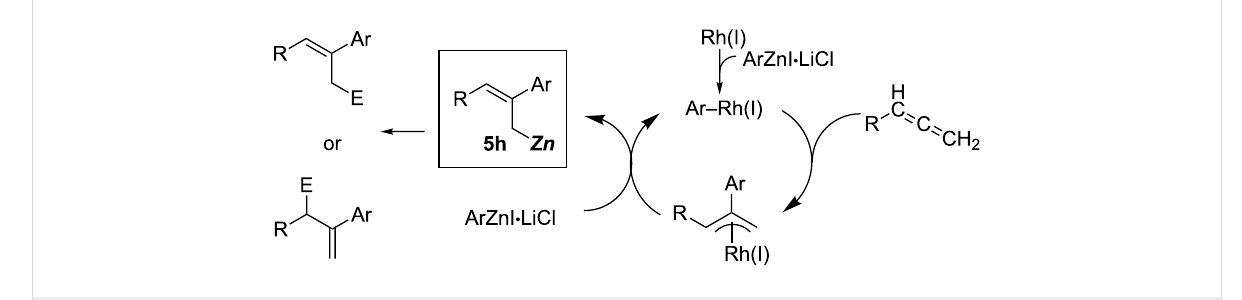
Scheme 49: Proposed mechanism for a rhodium-catalyzed arylzincation of allenes.